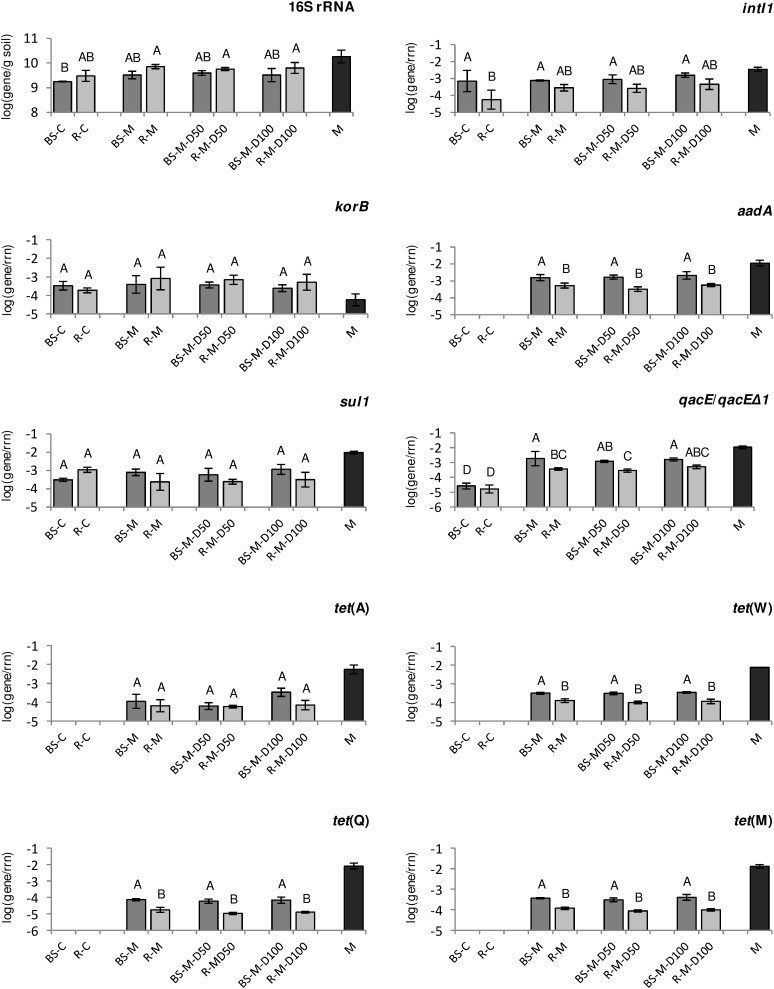
The abundance of the resistance genes, class 1 integron integrase gene, and korB specific for IncP-1 plasmids present in lettuce rhizosphere (R, light gray), bulk soil (BS, dark gray), and manure (M, black), obtained by TaqMan-based quantitative PCR (qPCR), relative to 16S rRNA genes (rrn). Error bars indicate the standard deviations of three replicates. Different letters indicate significant differences between soil treatments (p < 0.05, Tukey HSD).